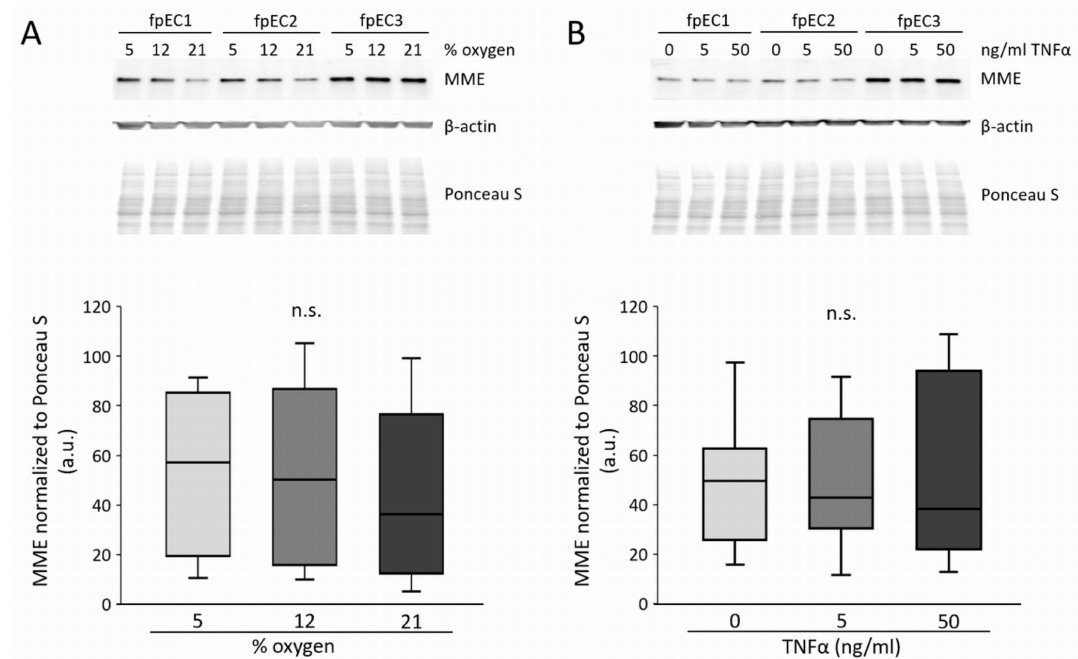
Figure 5. E ff ect of oxygen and tumor necrosis factor α (TNF α ) on MME protein in fpEC. ( A ) MME protein after culture at 5%, 12%, and 21% oxygen for 48 h. ( B ) MME protein after TNF α treatment (0, 5, and 50 ng / mL) for 24 h. Protein levels of β -actin were used as loading controls and protein was normalized to total protein staining with Ponceau S. Experiments were performed in n = 7 di ff erent fpEC isolations. Representative immunoblots of three fpEC isolations are shown on top. a.u.: arbitrary units; n .s.: not